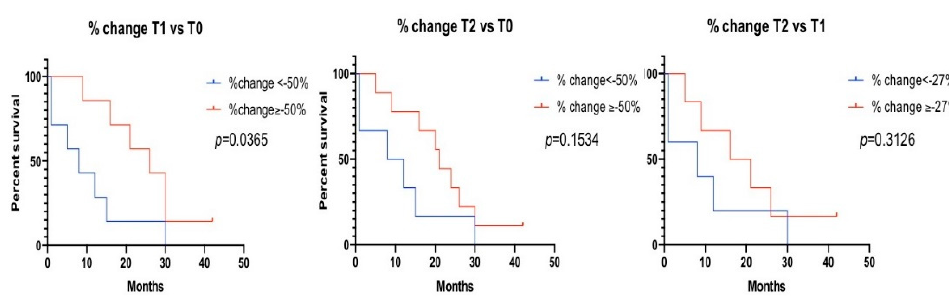
Figure 5. Overall survival and percent (%) change in GIN values at different time points. The overall survival of patients with a plasma % change in GIN values above and below the pre-established threshold ( − 50%) or the median ( − 27%). Left: % change T1 vs. T0, middle: T2 vs. T0 and right: T2 vs. T1.